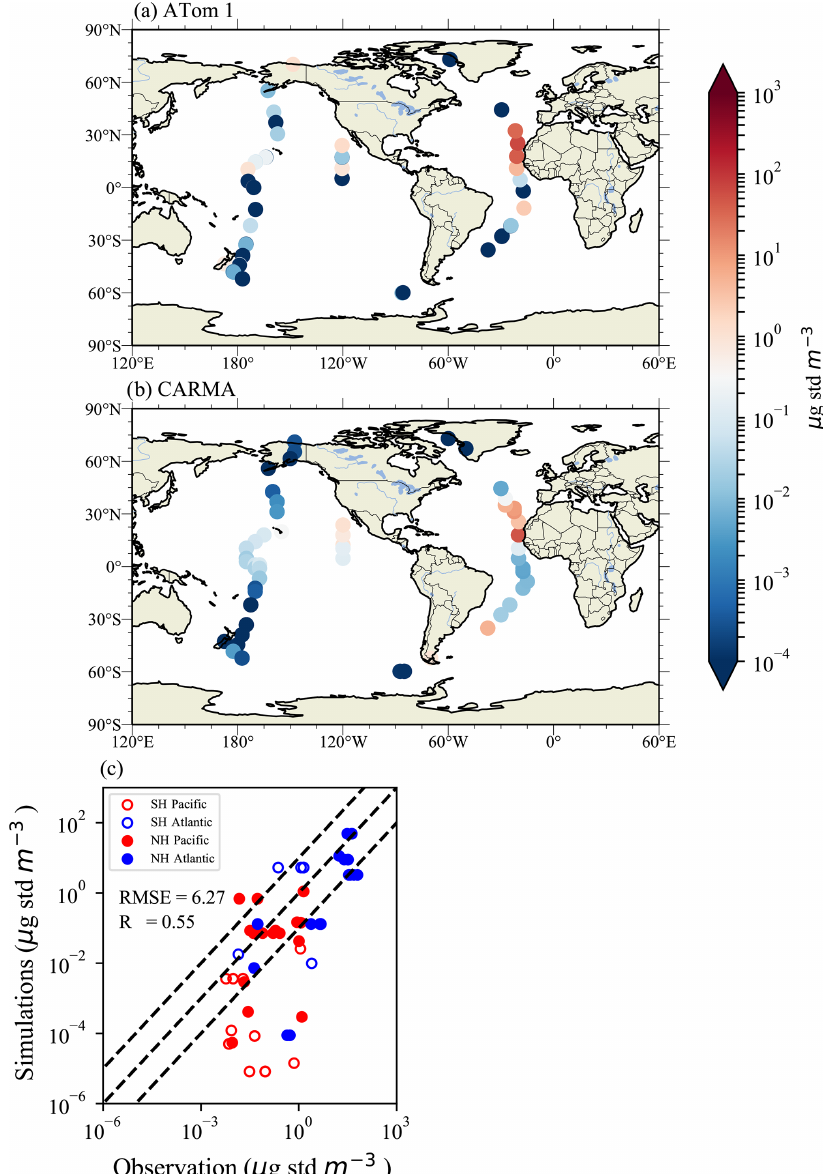
Figure 4. Comparison of the dust concentration below 900mb with a particle diameter of less than 4.5µm simulated by CESM1/CARMA with the NASA ATom-1 airborne campaign. Both model and observations are sampled along the NASA Atom-1 flight track. (a) Observed dust surface concentration according to ATom-1. Panel (b) is the same as panel (a) but with simulations from CESM1/CARMA. (c) Scatterplot of CARMA simulation compared with ATom-1 for dust surface concentration. Southern Pacific and Atlantic basin sites are denoted by red and blue circles, respectively, while the northern Pacific and Atlantic basin sites are denoted by red and blue points, respectively. The black dashed lines in each panel denote 1 : 10, 1 : 1, and 10 : 1 relationships between observations and simulations, respectively.